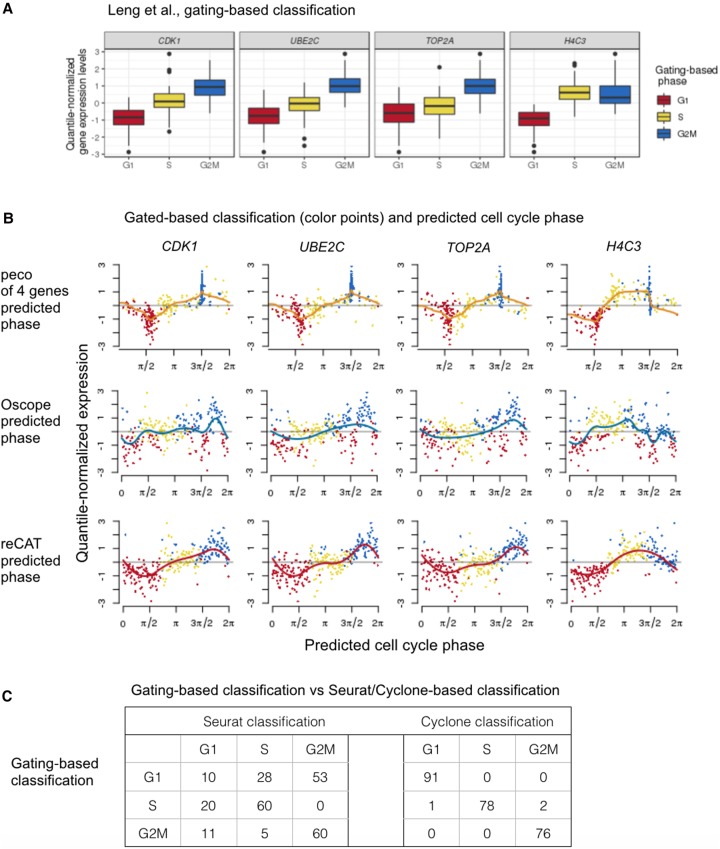
Applying peco and existing tools to data from Leng et al. (2015). The single-cell samples in this data were sorted into G1, S, and G2M phase. (A) We plot the distribution of gene expression for the top four cyclic genes per cell cycle phase. (B) We compare predicted phases based on peco, Oscope, and reCAT. Rows correspond to prediction results based on the three methods. Specifically, we sort the single-cell samples according to the predicted phase, and we color the sample points according to the gated phase. For example, in the first row, we show that the peak expression profile of peco prediction is consistent with results based on gating. The orange line corresponds to the cyclic trend of expression levels. (C) We compare the phase assignment based on gating with Seurat/Cyclone-based classification.